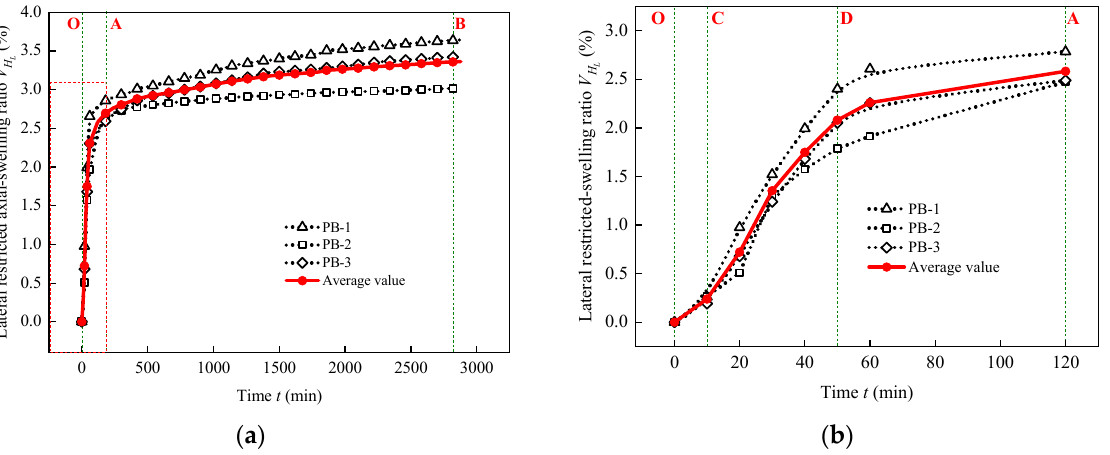
Figure 10. Axial lateral restricted ‐ swelling ratio. Variation in axial lateral restricted ‐ swelling ratio for ( a ) 2880 min and ( b ) during the first 120 min. Table 4. Lateral restricted ‐ swelling ratio.